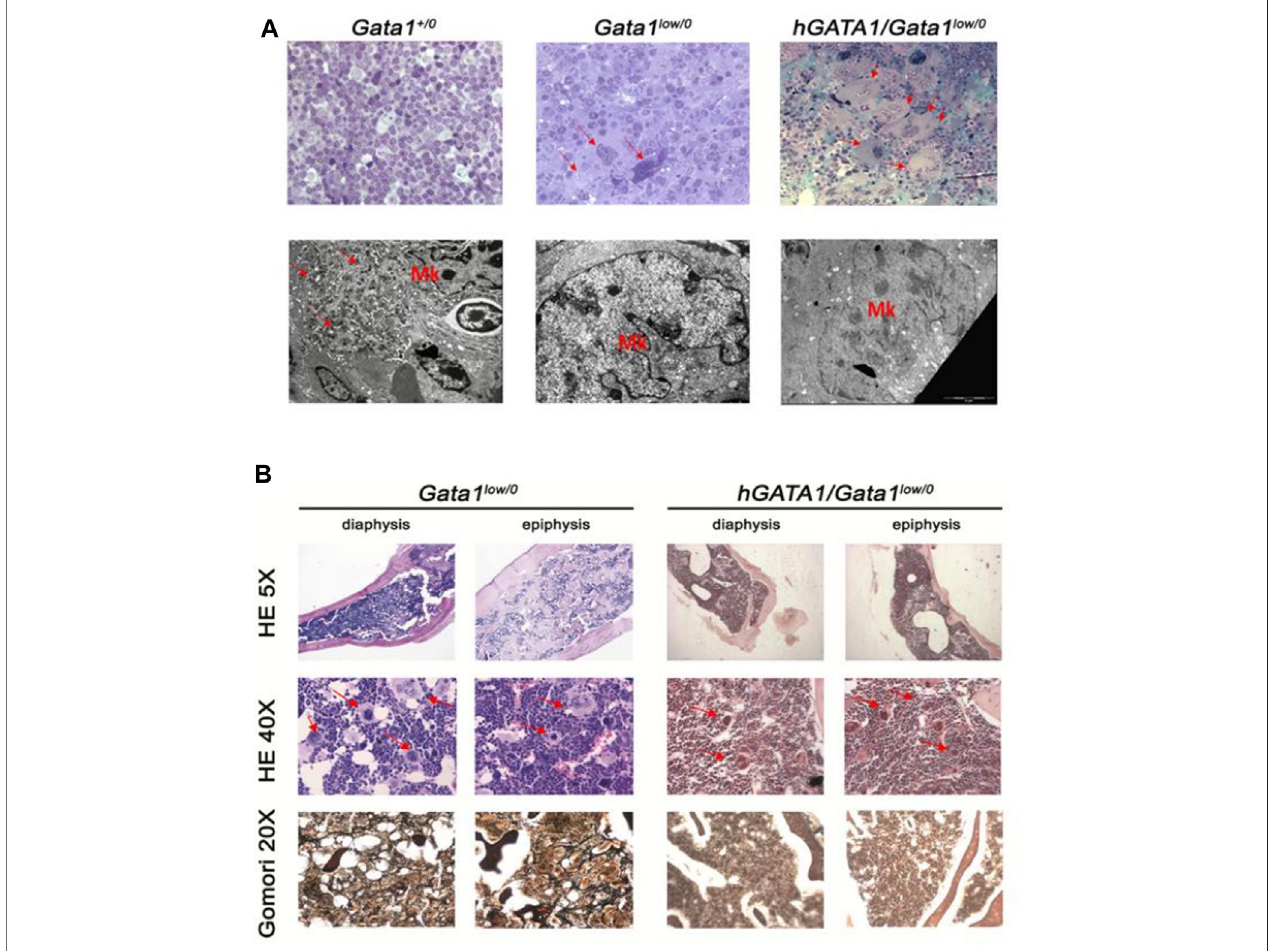
FIGURE 8 | The presence of hGATA1 rescues fi brosis in the bone marrow of Gata1 low/0 mice without decreasing the great number of abnormally immature megakaryocytes present in their organs. (A) Top panels: semithin sections of spleens from representative Gata1 +/0 , Gata1 low/0 and hGATA1/Gata1 low/0 mice, as indicated (magni fi cation 40X). By contrast, with Gata1 +/0 mice, megakaryocytes (MK) both from the spleen [arrows in (A) ] of both Gata1 low/0 and hGATA1/Gata1 low/0 mice are organized in clusters of small cells. Lower panels: transmission electron microscopy analyses of representative megakaryocytes from the spleens of Gata1 +/0 , Gata1 low/0 and hGATA1/Gata1 low/0 mice (magni fi cation 4,400X). By contrast with the well organized platelet territories and heavily electron dense granules present in the cytoplasm of wild-type megakaryocytes, the cytoplasm of megakaryocytes from both Gata1 low/0 and hGATA1/Gata1 low/0 mice is poorly partitioned into plateletterritoriesandcontainsgranuleswithlight-electrondensity,anindicationofpoorproteincontent. (B) Histologicalsectionsofthediaphysisandepiphysisregionof femurs from Gata1 low/0 and hGATA1/Gata1 low/0 mice, as indicated. The upper and middle panels present hematoxylin-eosin (HE) staining of representative transversal sections from Gata1 low/0 (left) and hGATA1/Gata1 low/0 (right) mice at 5X (top panels) and 40X (middle panels) magni fi cations to highlight details of the bone and of the medulla,respectively.The5Xmagni fi cationshowsthatthefemurfromboth Gata1 low/0 and hGATA1/Gata1 low/0 micecontainsnumerousbonetrabeculaeinitsdiaphysis and thicker compact bone sections in its epiphysis, an indication of active osteogenesis while the space inside the bone available for the medulla is limited. The 40X magni fi cation shows the presence in the medulla from both experimental groups of numerous clusters of megakaryocytes (red arrows) similar to those which were observedinthespleen[panel (A) ].TheGomoristaininginthebottompanels(magni fi cation20X)indicatespresenceof fi brosisinthemedullaof Gata1 low/0 micebutnotin that from hGATA1/Gata1 low/0 . littermates. Results are representative of those observed in 3 mice per experimental groups.